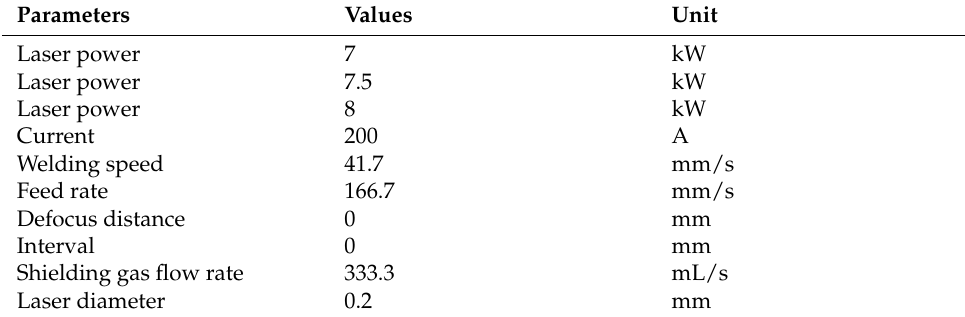
Table 2. Welding experimental